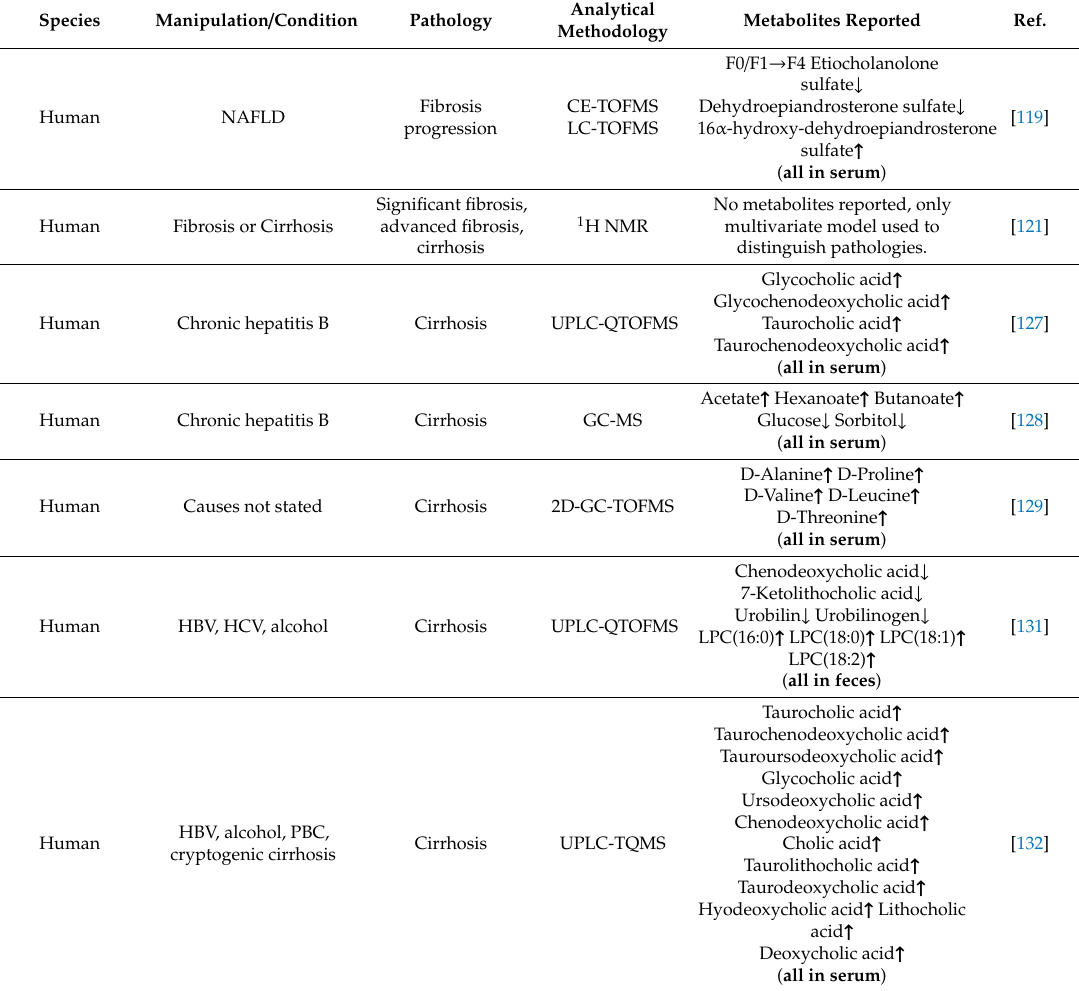
Table 3. Metabolomic and lipidomic biomarkers of liver fibrosis and